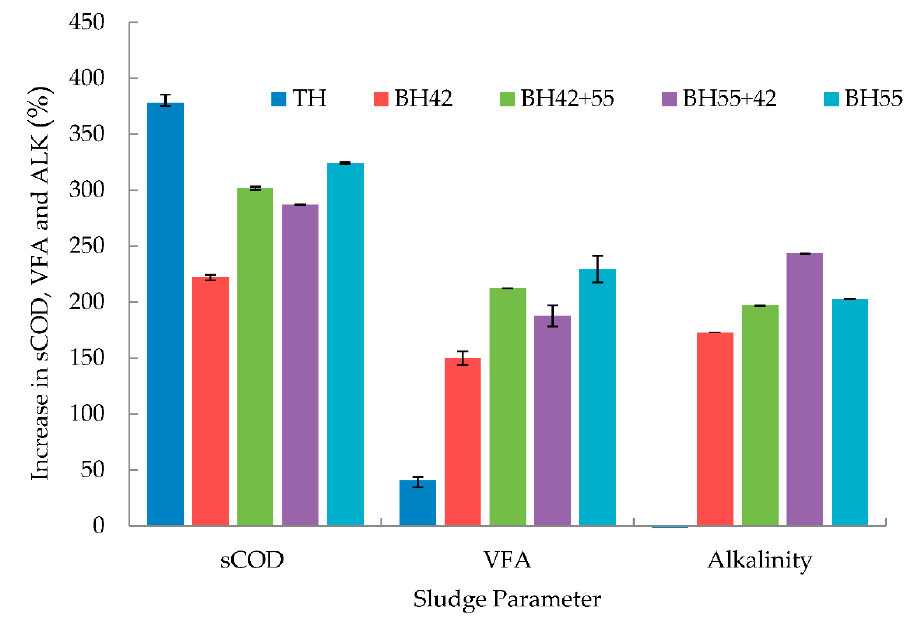
Figure 3. Increase in sCOD, VFA, and alkalinity concentration caused by TH and BH